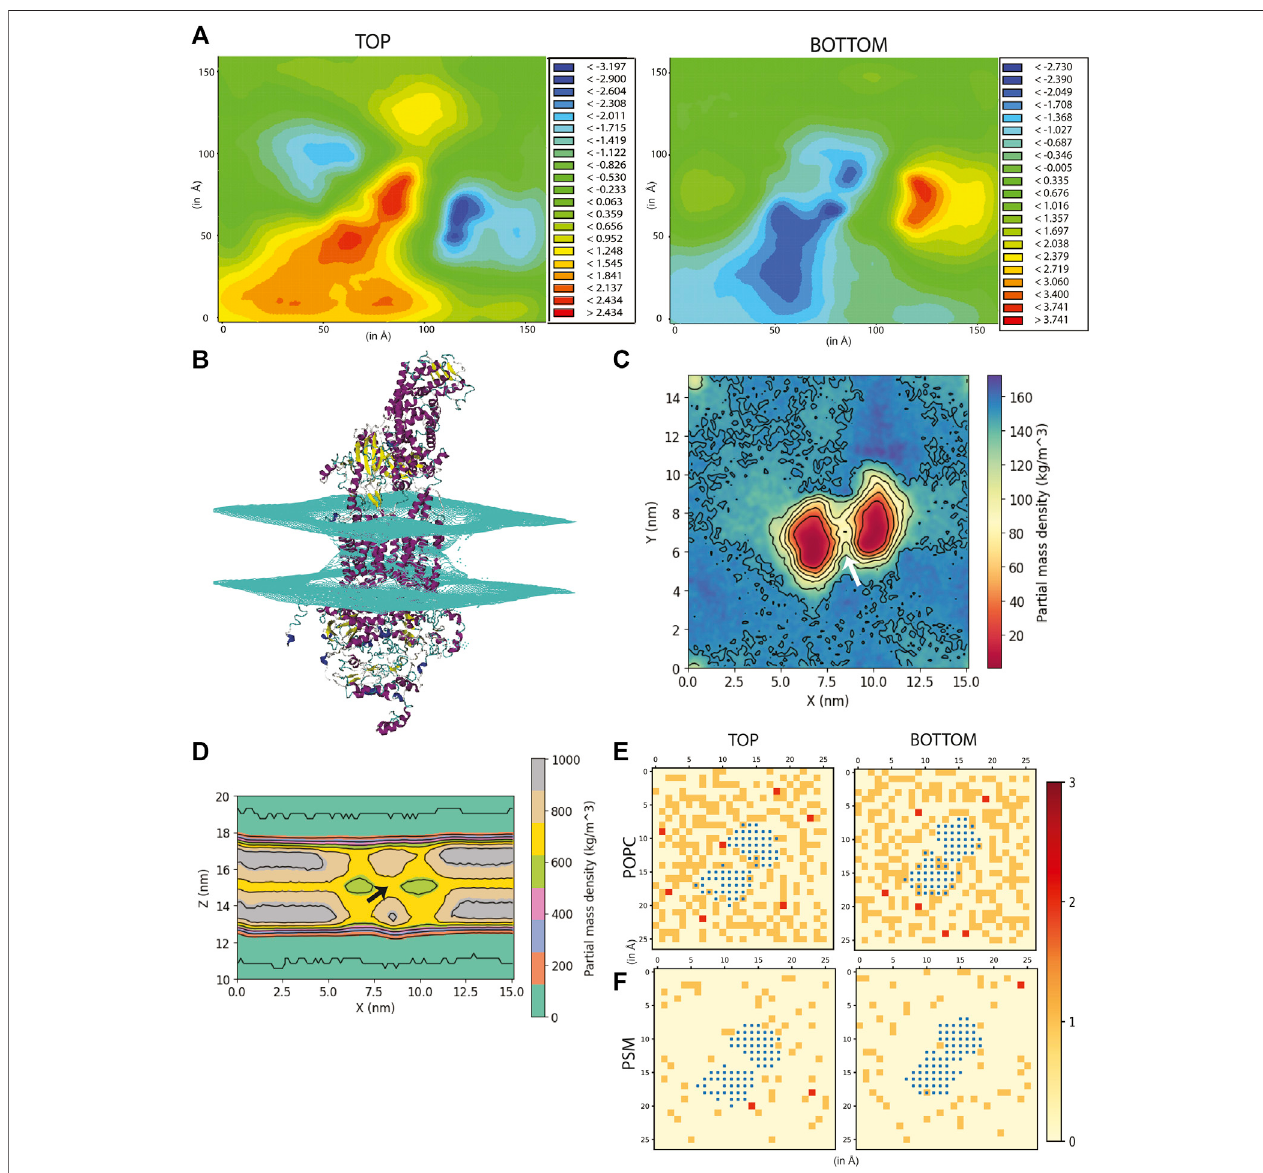
FIGURE 2 | Effect of ABCA1 on membrane curvature and dynamics. (A) Heat maps depicting average membrane thickness of the top and bottom lea fl et of the membranethroughout simulation. (B) Curvatureinducedinthemembraneduetopresence ofprotein. Partialdensityoflipidsacrosstwolea fl ets along (C) XY -planeand (D) . XZ -plane.Arrow[coloredwhiteandblackin (C,D) respectively]depictstheislandoflipidswithintheTMDs.Lipidclusteringshowingthefrequencyoflipids(shownas red,orangeandcream)of (E) .POPCand (F) .PSMaroundprotein(coloredblue).Themembraneisdividedintosquareboxofedge6 (cid:1) A eachandfrequencyineach of these boxes has been computed and depicted in the fi